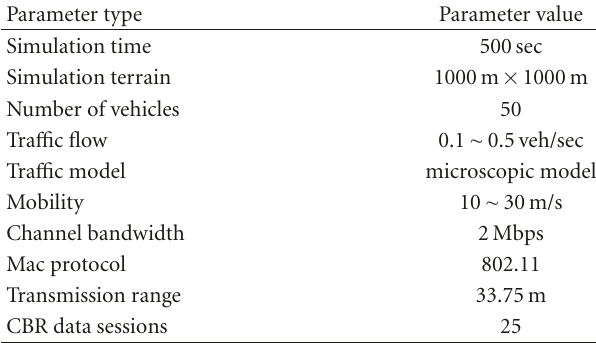
Table 1: Simulation